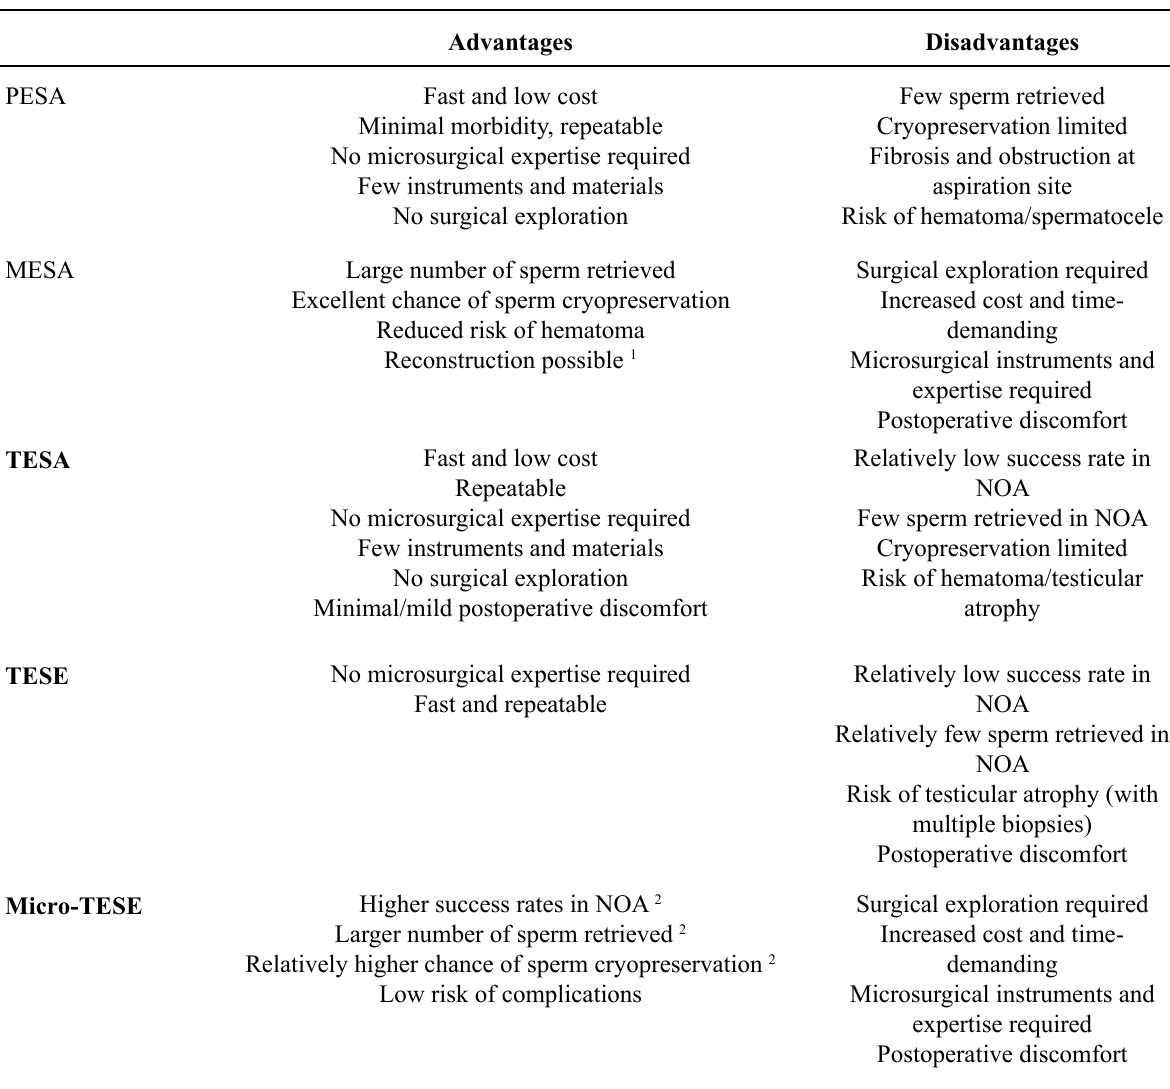
Table 2 - Advantages and Disadvantages of Sperm Retrieval Techniques for Assisted